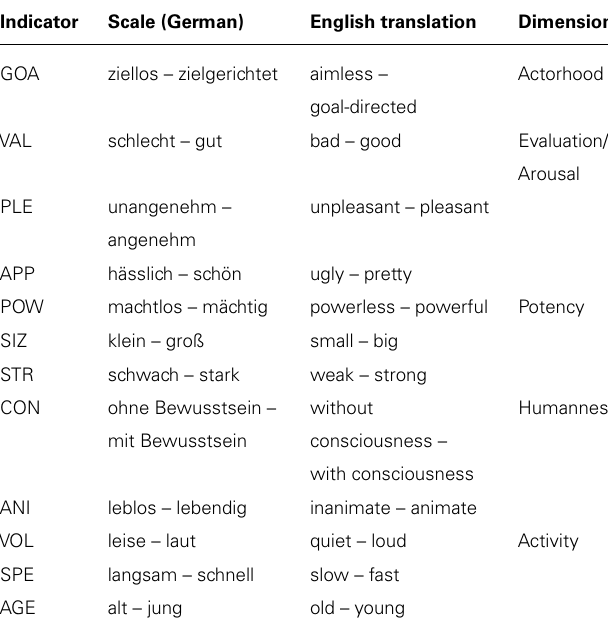
Table 1 | Scales used in Experiment 1, abbreviated in terms of indicators (observed